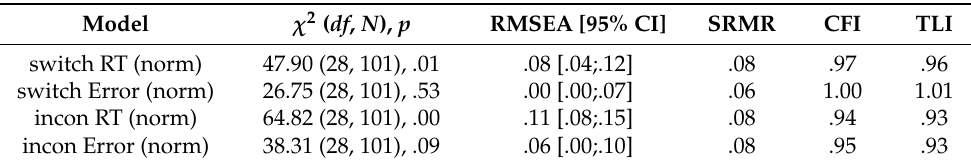
Table A2. Fit of the LDS models for observed performance scores.